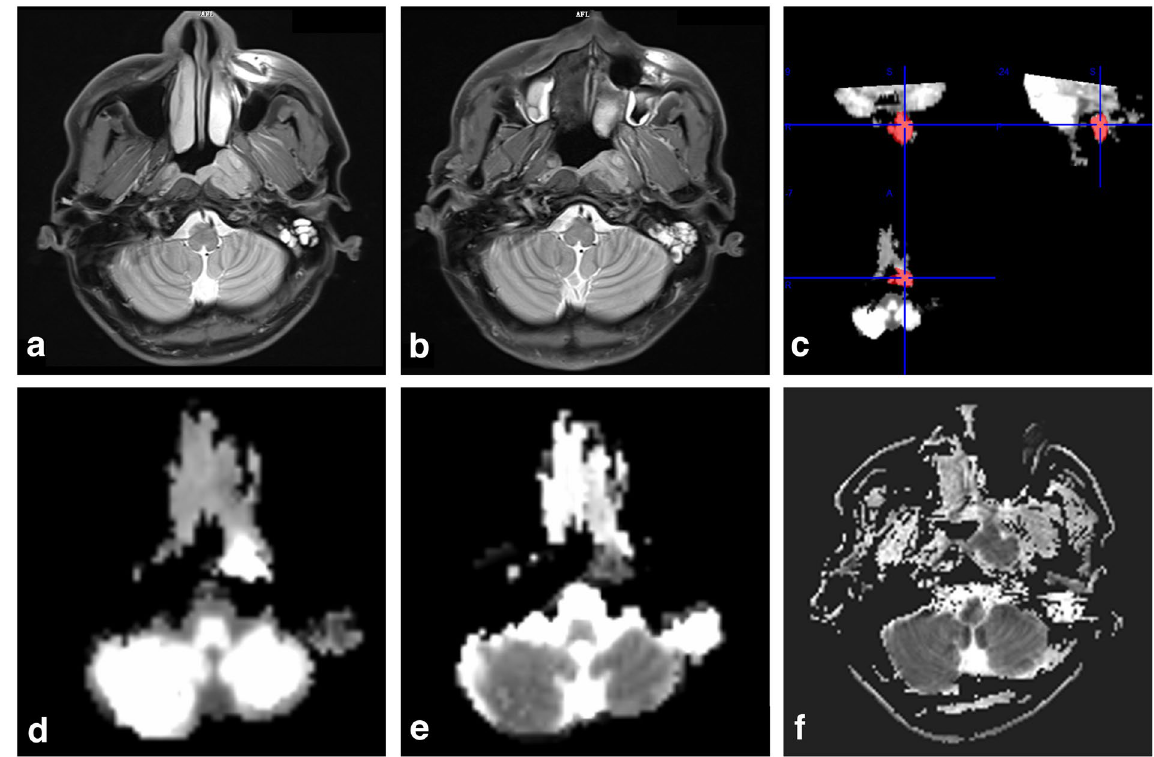
Figure 2. A 23-year-old man with NPC in NRG. Pre-treatment axis PdWI ( a ) showed lesions located at the left nasopharyngeal wall and cavum. Residual tumor was detected after radiotherapy ( b ). A manual drawing of an ROI within the boundaries of the NPC lesion on the Kmean map is also shown ( c ). The Dmean ( d ) and Kmean ( e ) values were 0.96 × 10 -3 mm 2 /s and 0.95 before treatment, respectively. The ADC min ( f ) was 754 × 10 -3 mm 2 /s before treatment.